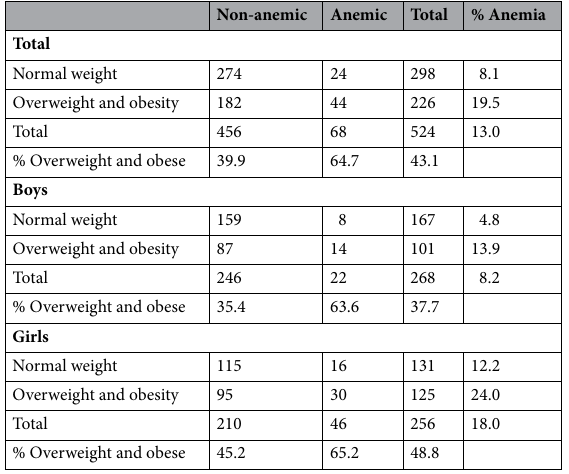
Table 2. Coexistence of anemia and overweight/obesity in adolescents.